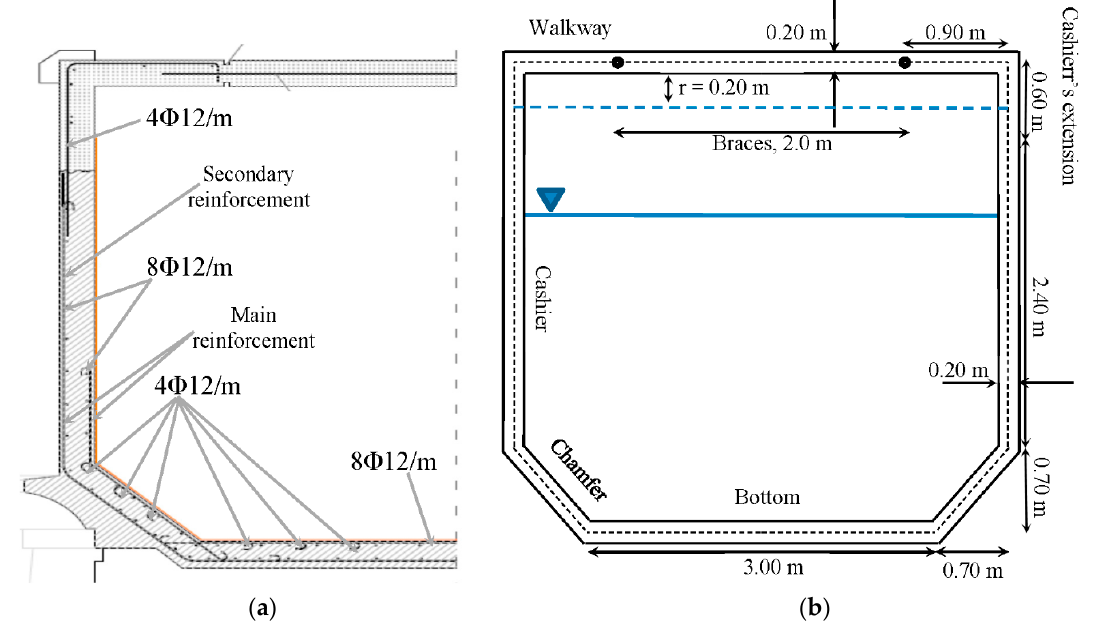
Figure 4. ( a ) Main tensile reinforcement configuration and ( b ) geometry of the cross-section.